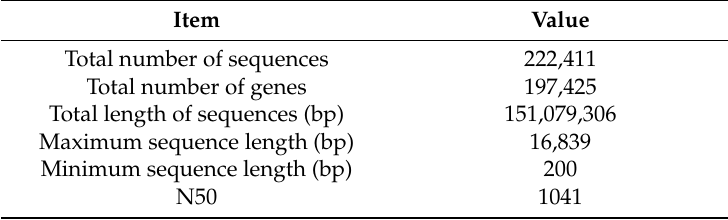
Table 2. Overall assembly statistics for the transcriptome of M.